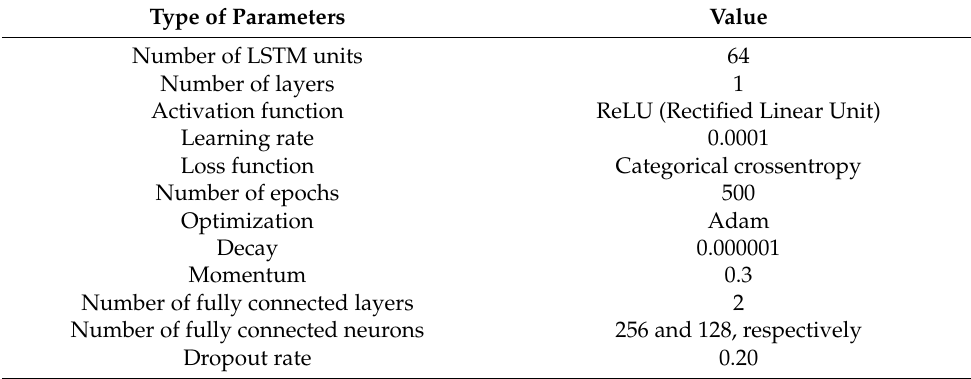
Table 2. Parameters of the designed deep learning model.